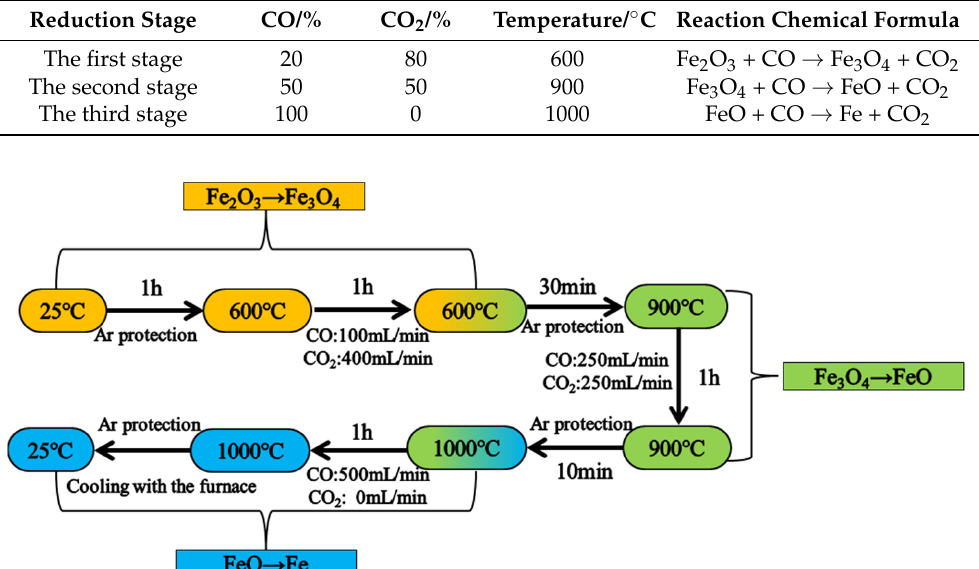
Table 4. Parameters of three stages of pellet reduction.